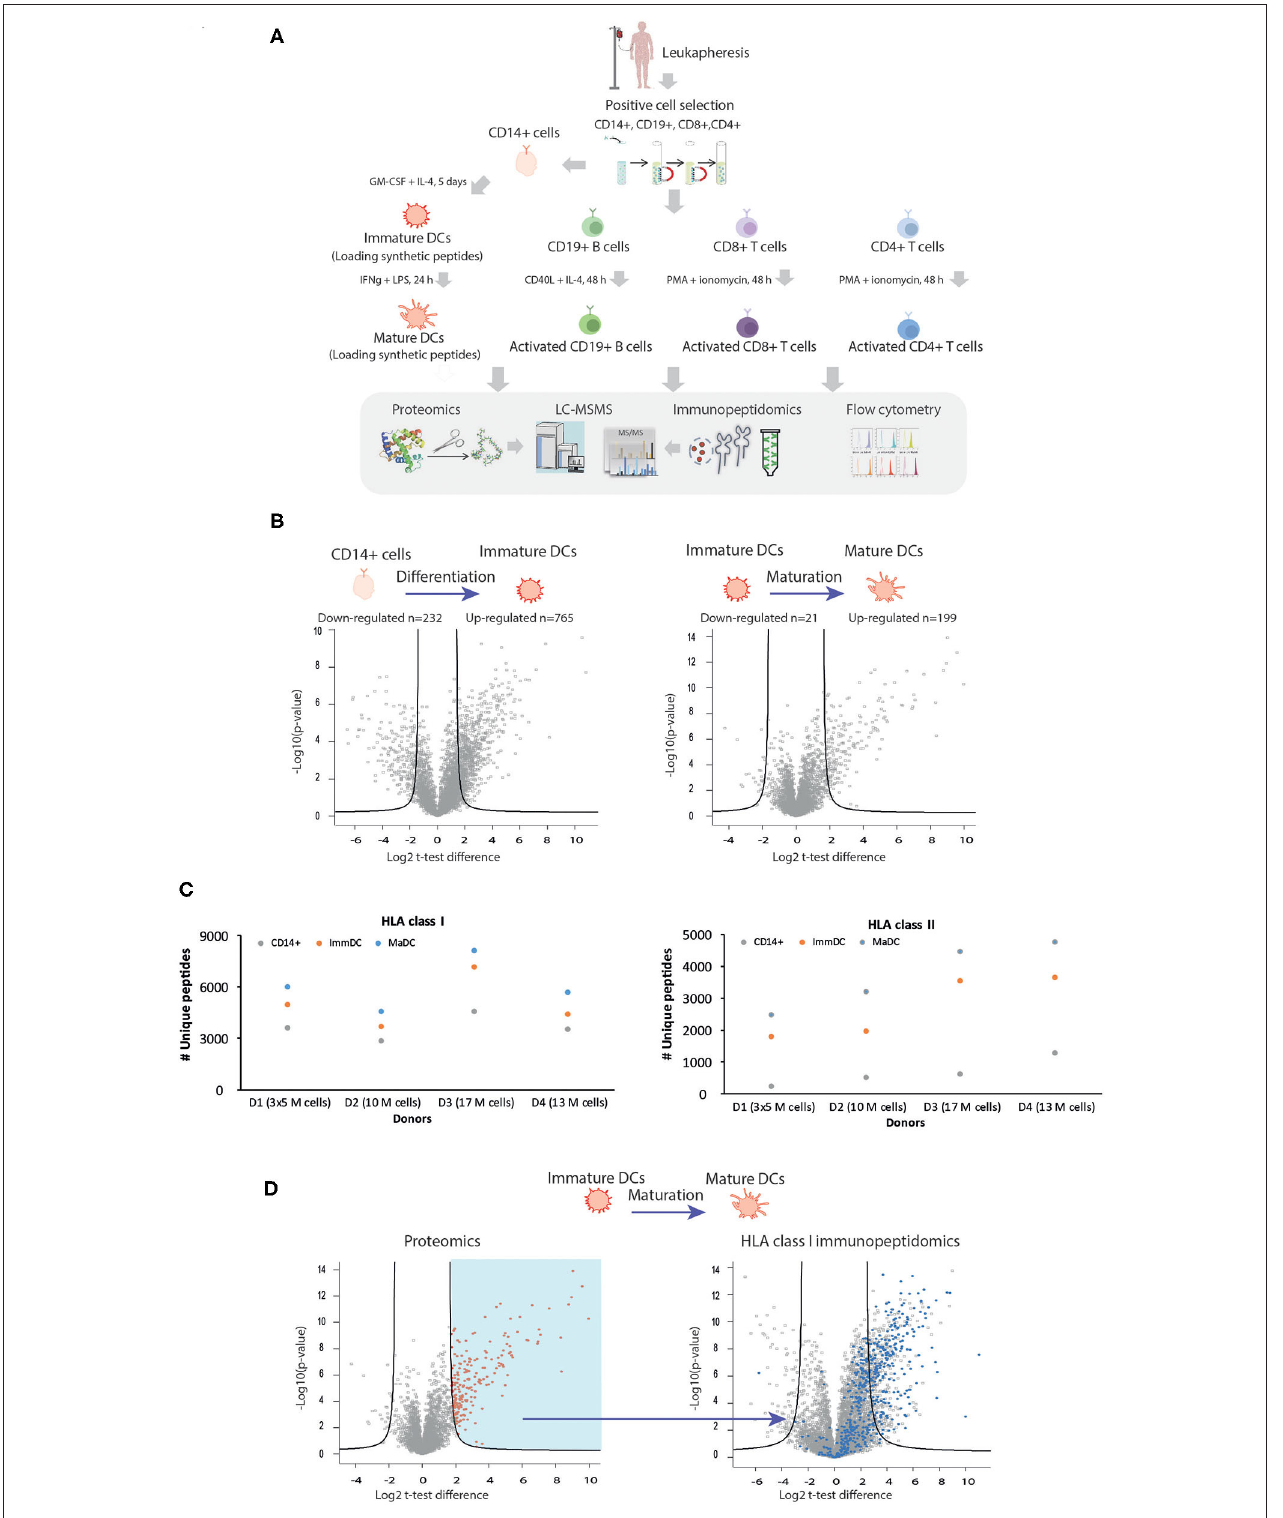
FIGURE 1 | Characterization of the repertoire of HLA class I and class II ligands in different cell types with MS-based immunopeptidomics and proteomics approached. (A) Description of the experimental workflow. Gradient separation was used to isolate PBMCs from healthy donors’ leukapheresis or apheresis samples